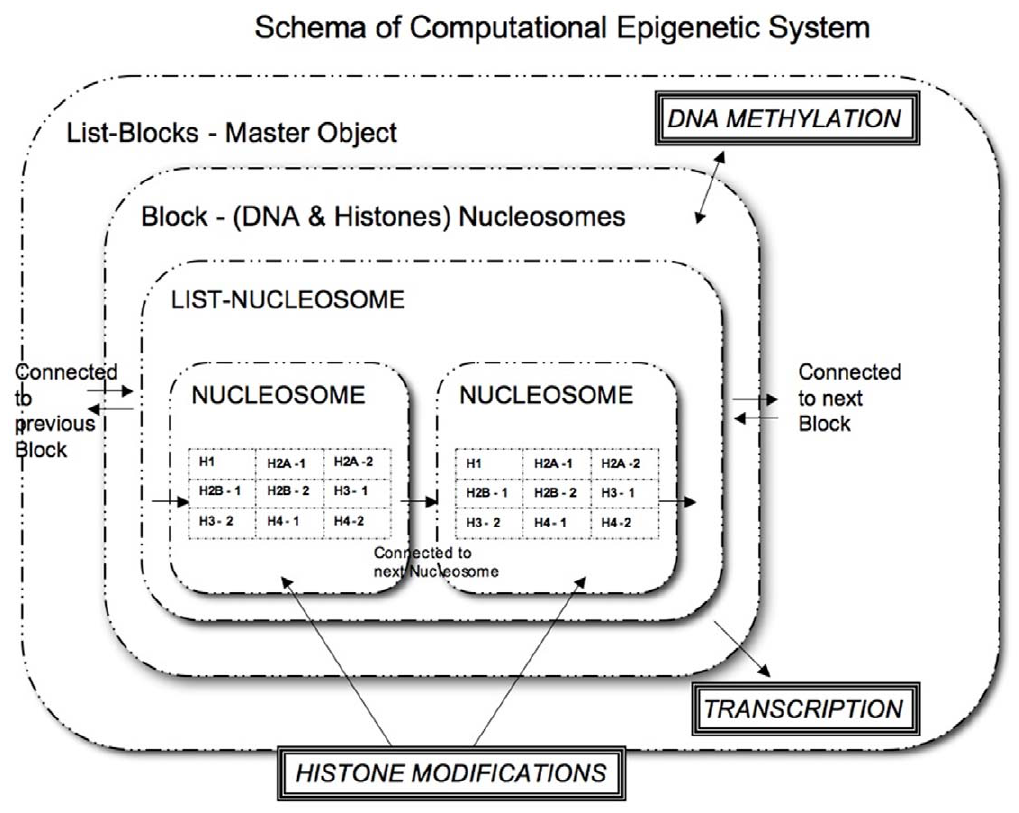
Figure 1. Schema of the Computational Epigenetic Micro-model. Structure and layers of our computational model closely represent known epigenetic mechanisms. The master Object is List-Block which generates a Block of genes. Contained inside each Block are the DNA and Histone objects forming Nucleosome unit. There are 8 histone objects - pairs of H2A,H2B,H3 and H4 along with one H1 object. Each of the histone objects are updated with the modifications over each time-step during the simulation. Hence during each time step, the model is aware of the Histone modifications and DNA Methylation which defines the system evolution.